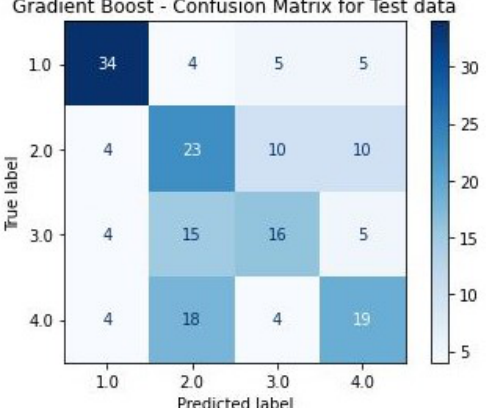
Figure 7. Gradient Boost Decision Tree—Confusion Matrix for Test Data. Class 1 obtained the majority of correct predictions, whereas the rest of the classes have a modest number of accurate data